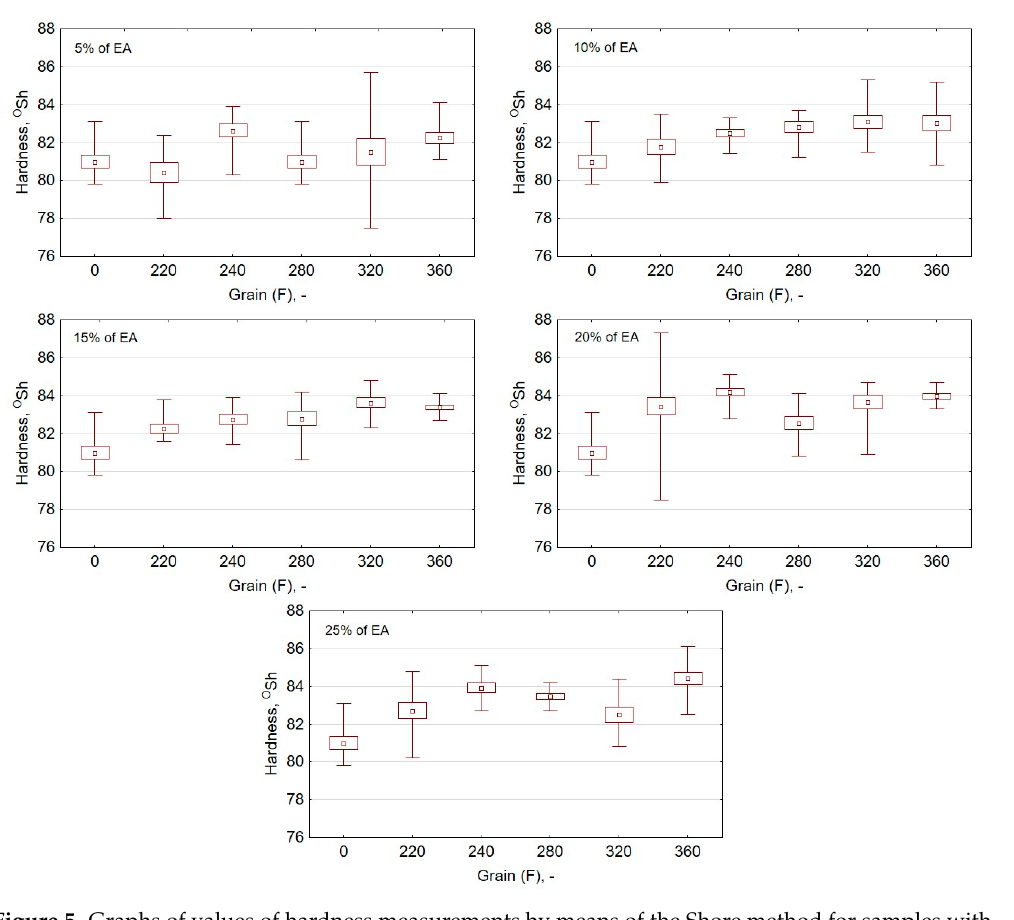
Figure 5. Graphs of values of hardness measurements by means of the Shore method for samples with an addition of alundum of different grain for mass percentage share of the physical friction modifier equal to 5, 10, 15, 20, and 25%, respectively.